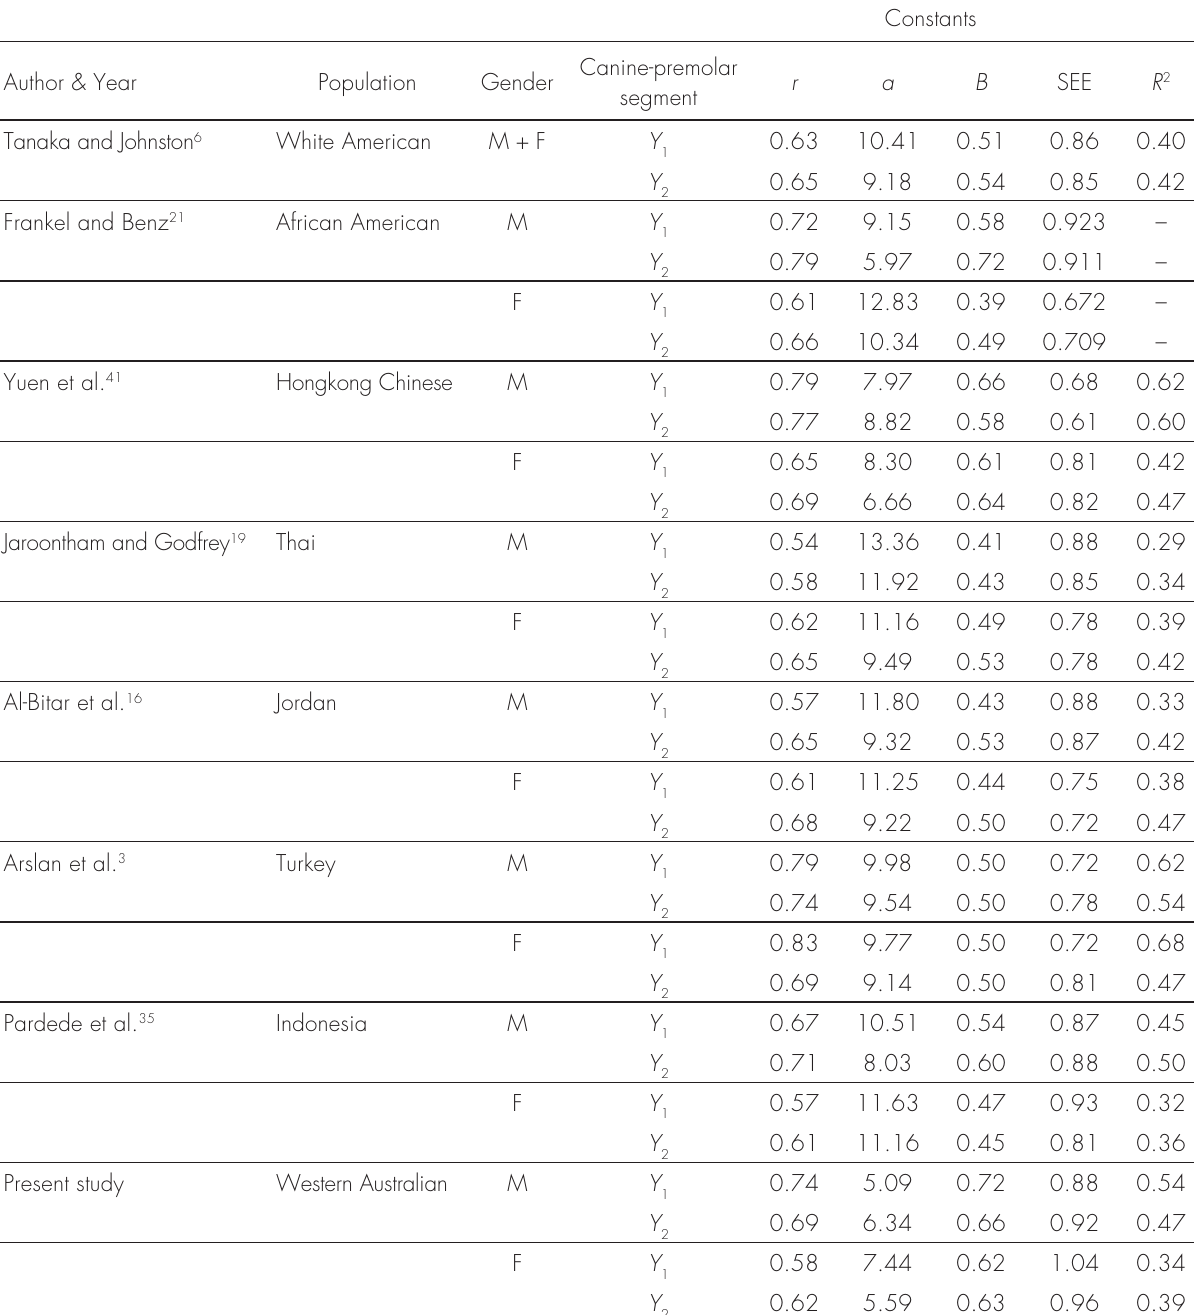
Table VI. Comparison of regression parameters between the present study and other